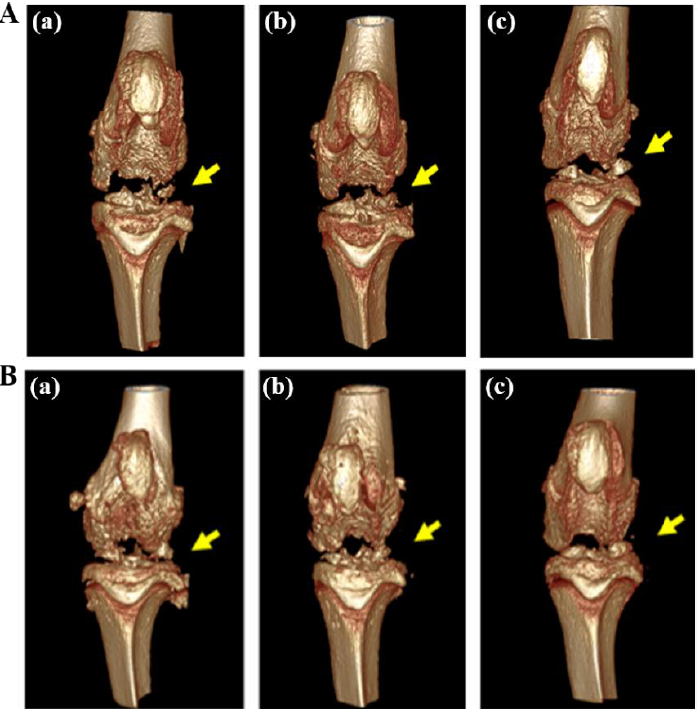
Figure 6 . Micro-CT images of a rheumatoid arthritis model rat at 1 week ( A ) and at 2 weeks ( B ) after injection of saline (a), Dex (b), and Dex-RMSNs (c). Yellow arrow shows the place of erosion.